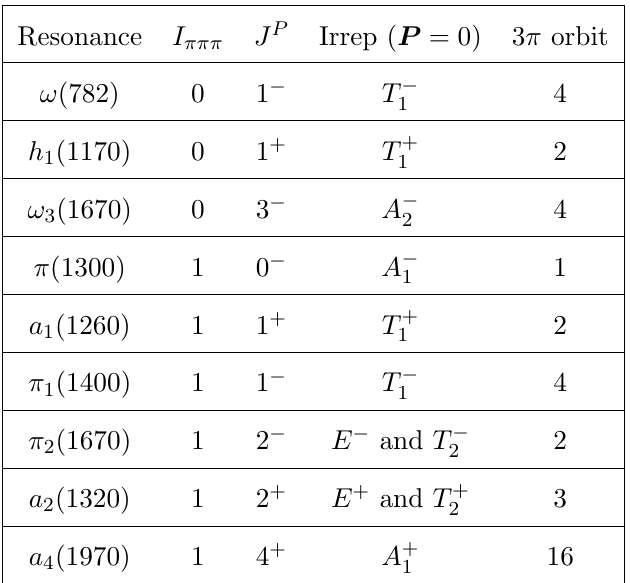
Table 4 . Lowest lying resonances with negative G-parity, and which couple to three pions, in the di(cid:11)erent isospin and J P channels. The fourth column shows the cubic group irreps that are subduced from the rotation group irreps, assuming that the resonance is at rest ( P = 0). The (cid:12)nal column gives the lowest three-pion momentum orbit that contains the corresponding cubic group irrep, again assuming P =